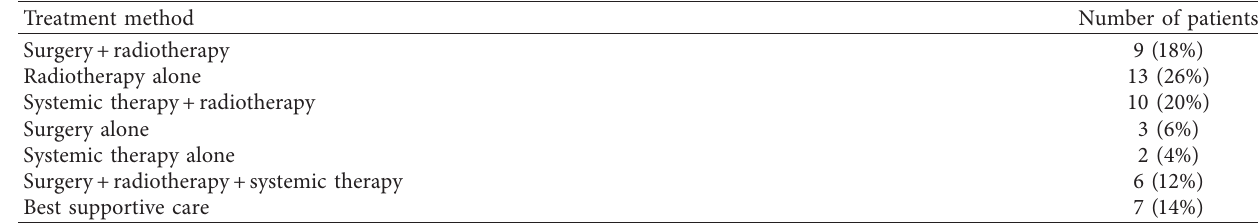
Table 3: Treatment modalities after diagnosis of melanoma.